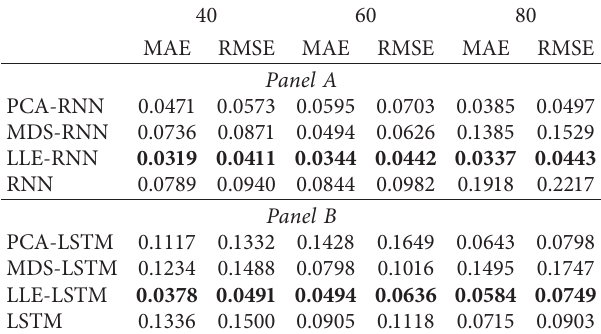
Table 9: Error with different window sizes (future prices).